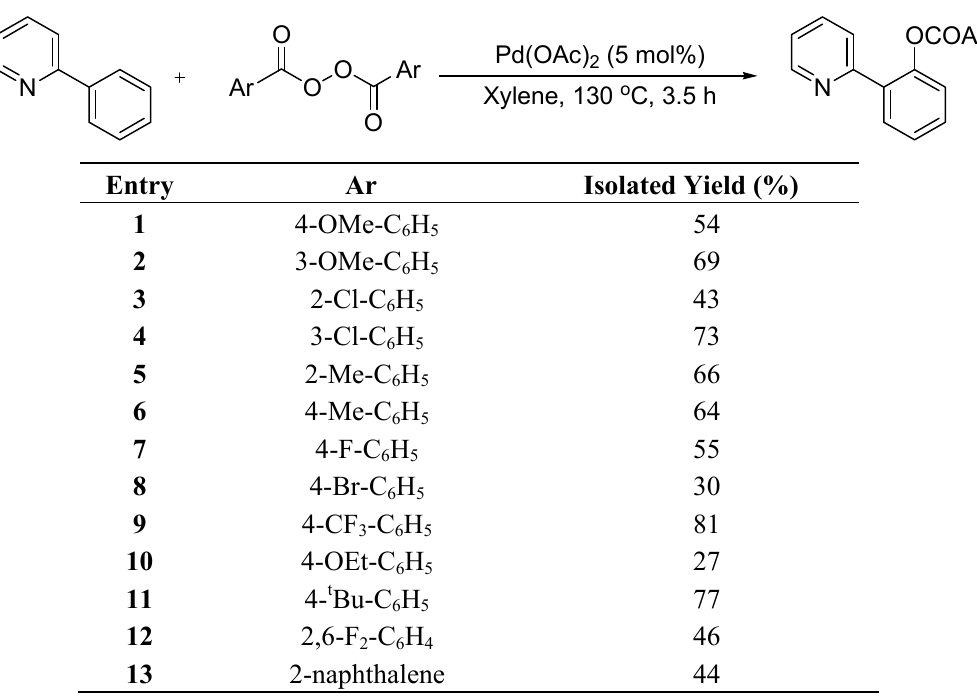
Table 4. Benzoxylation with various aryl acylperoxides a